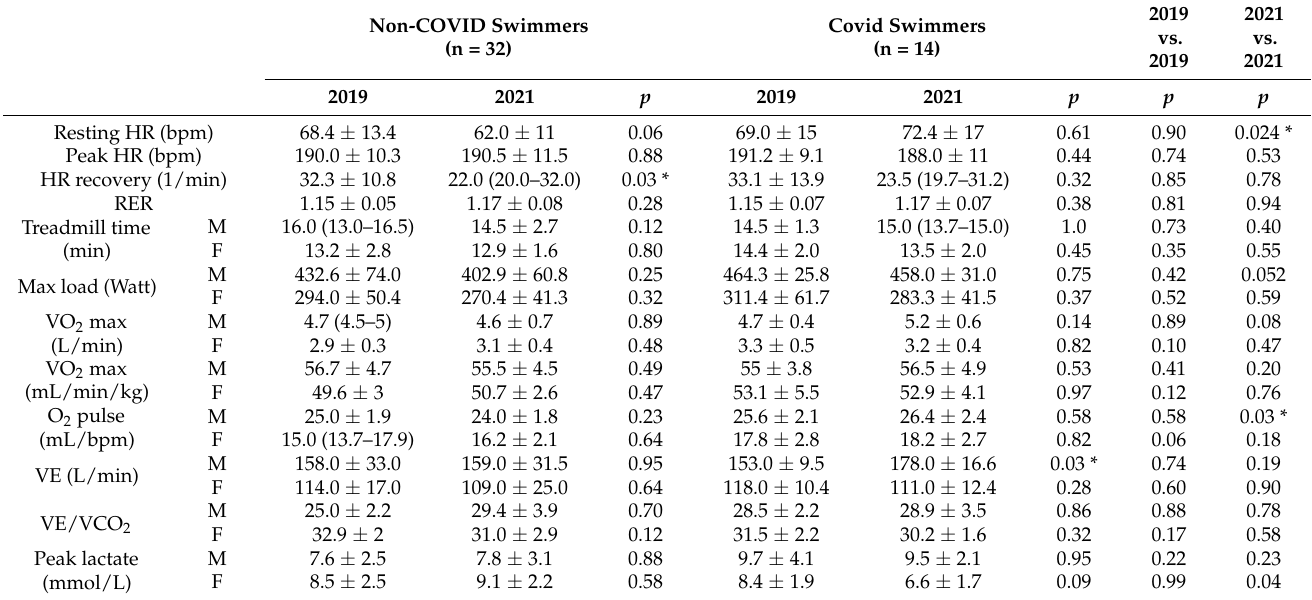
Table 3. Cardiopulmonary exercise testing